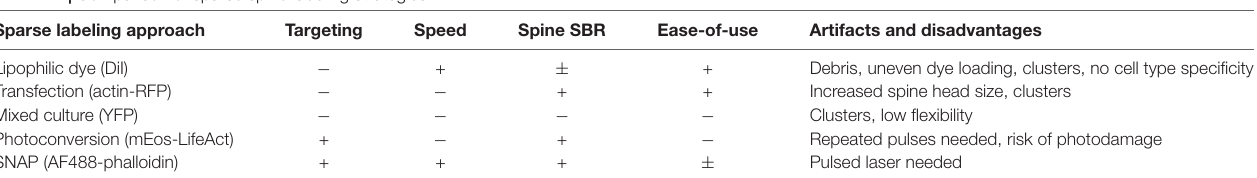
TABLE 2 | Comparison of sparse spine labeling